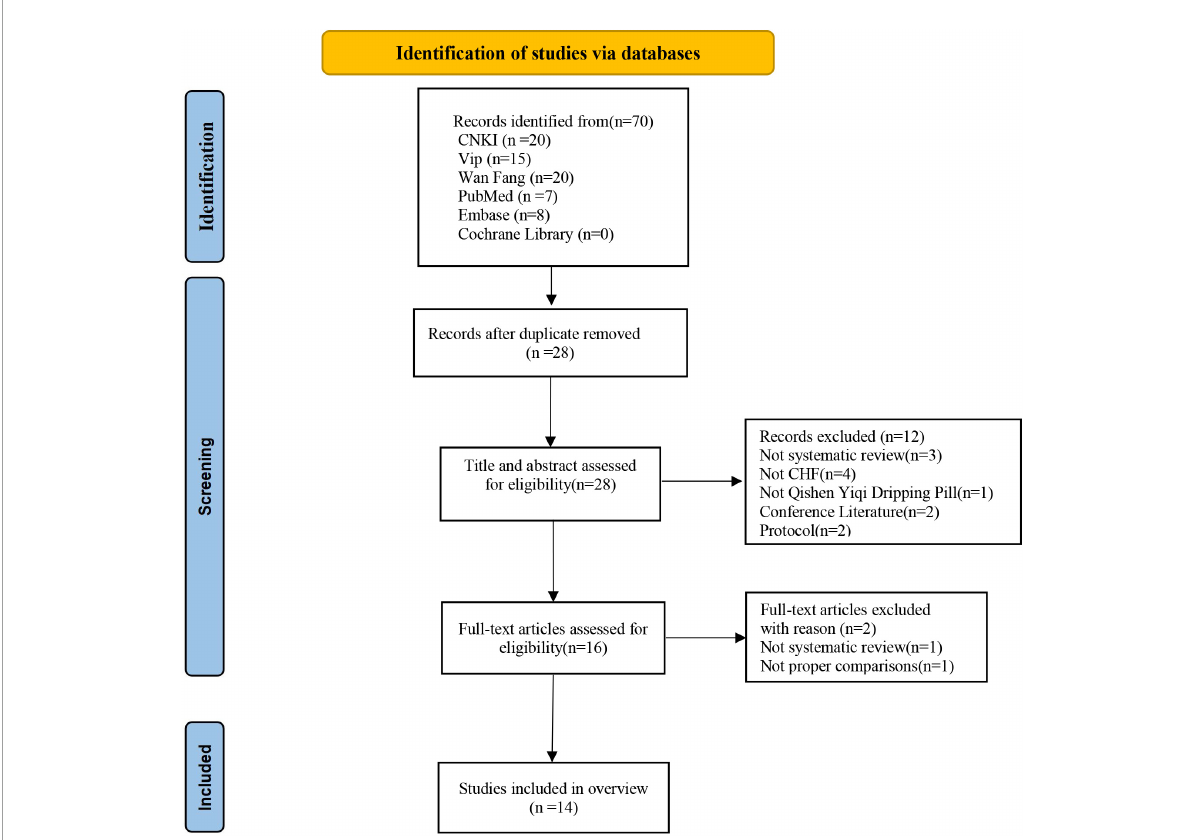
FIGURE1 Flow chart of the study selection process. CHF, chronic heart failure; CNKI, China National Knowledge Infrastructure database; Embase, Excerpta Medica database; SR, systematic